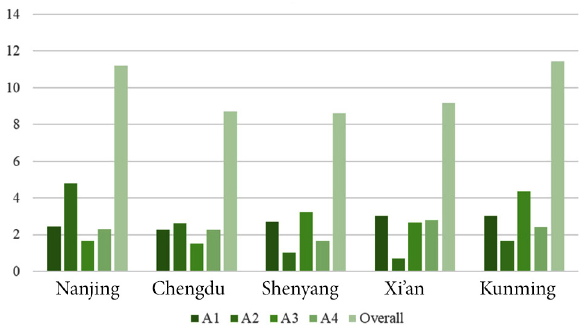
Figure 4. Measuring results of disaster prevention capability of urban park system in five